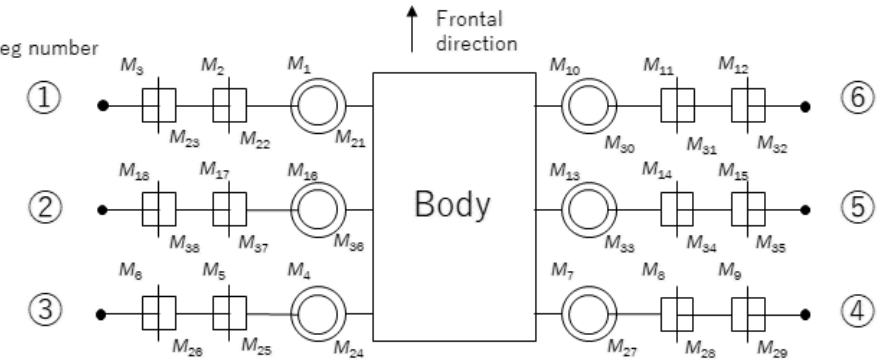
Figure 4. Joint placement and structure of Robot 1 in top view. All the joints are rotational joints. The end point of each leg has a touch sensor, as described above. Leg numbers are assigned in this figure, for the control. Motor IDs M 1 to M 18 are assigned to the virtual agent, and motor IDs M 21 to M 38 are assigned to Robot 1.